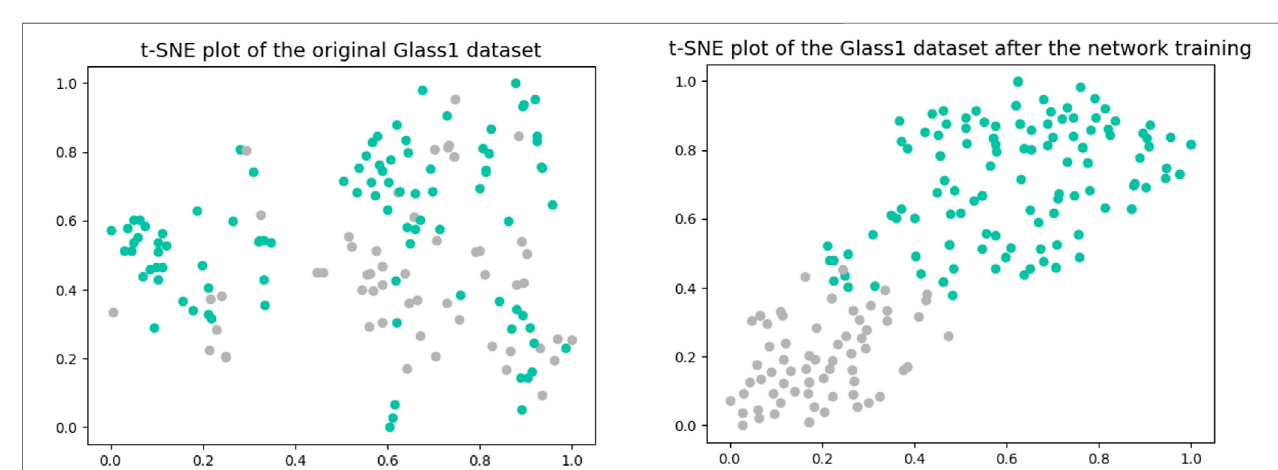
FIGURE 3 | t-SNE plots of the original Glass1 dataset and after the network training.